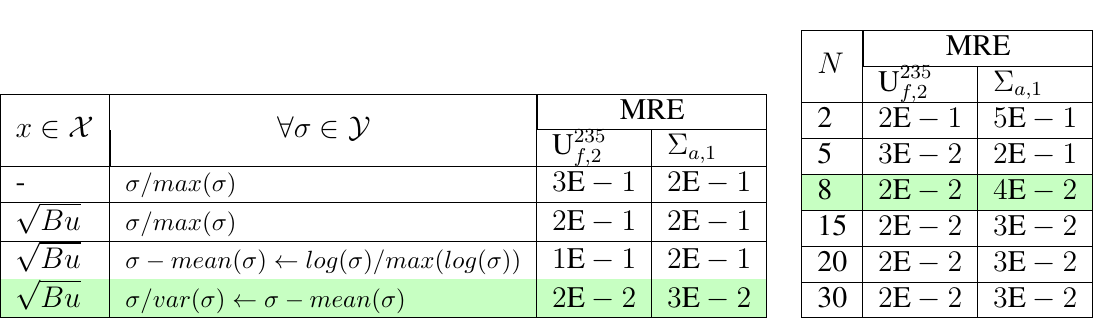
Table 1: Data normalizations. Table 2: Increasing N in Shallow ANN.